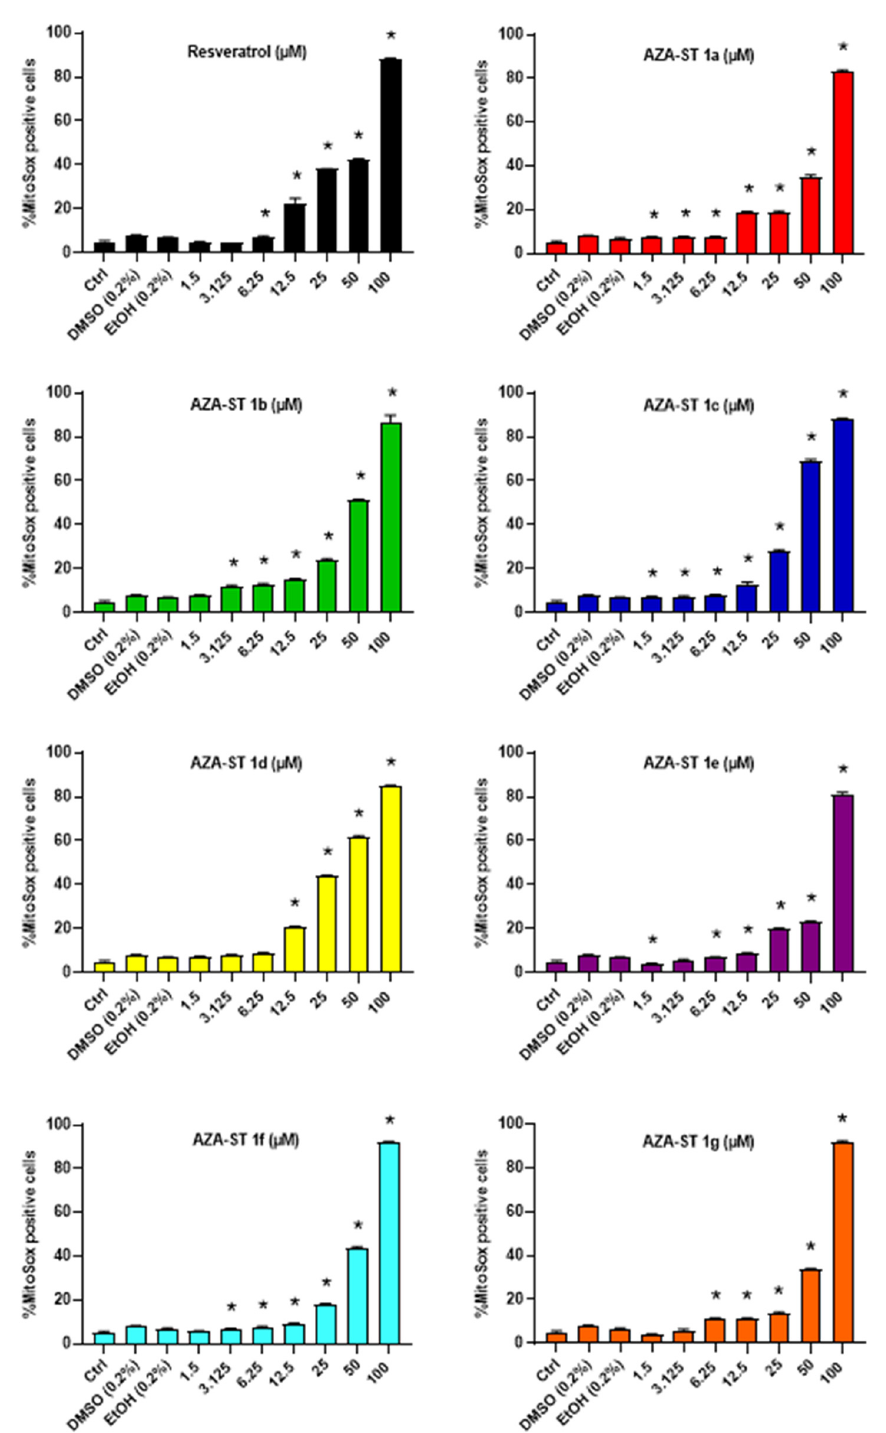
Figure 7. Flow cytometric evaluation of the effects of AZA-ST 1a–g and resveratrol on ROS overpro- duction at the mitochondrial level by staining with MitoSox Red. N2a cells were incubated for 24 h with or without AZA-ST 1a–g or resveratrol (RSV; trans -resveratrol) at concentrations from 1.5 to 100 µM. Vehicles (Ethanol (EtOH) for RSV; DMSO for AZA-ST) [15]: Ethanol (EtOH; 0.2%) and DMSO (0.2%); the highest concentrations of vehicles were the only ones analyzed. The data are the mean ± standard deviation (SD) of three independent experiments performed in triplicate. The comparison of the data was performed with an ANOVA test followed by a Bonferroni test. (*): p ≤ 0.05 was considered statistically significant.